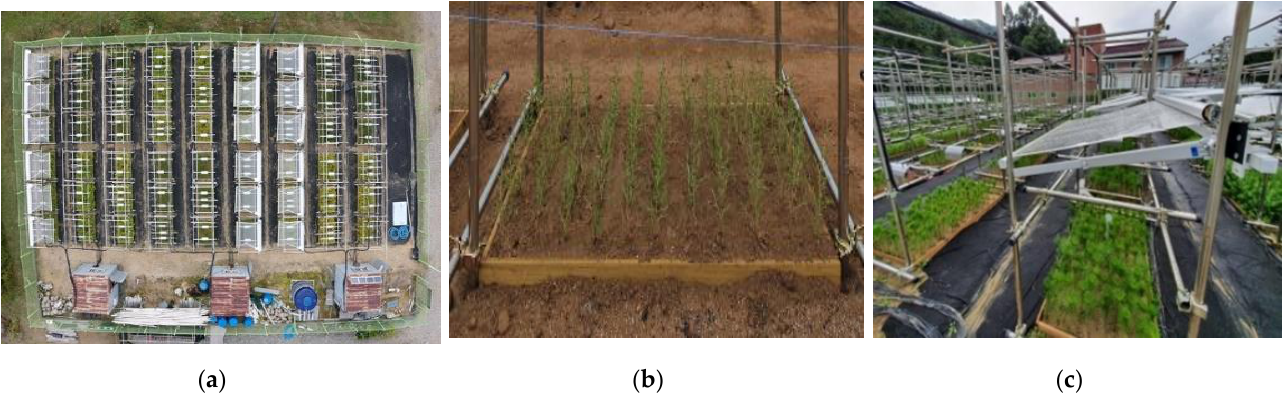
Figure 1. ( a ) Overview of the open-field experiment of extreme climate event manipulation; ( b ) one-year-old Larix kaempferi (Lamb.) Carr. seedlings ( n = 88) planted in a plot of 1.5 × 1.0 m; and ( c ) climate manipulation systems using infrared heating lamps for warming, rain shelters for drought, and irrigation spraying for heavy rainfall treatments.